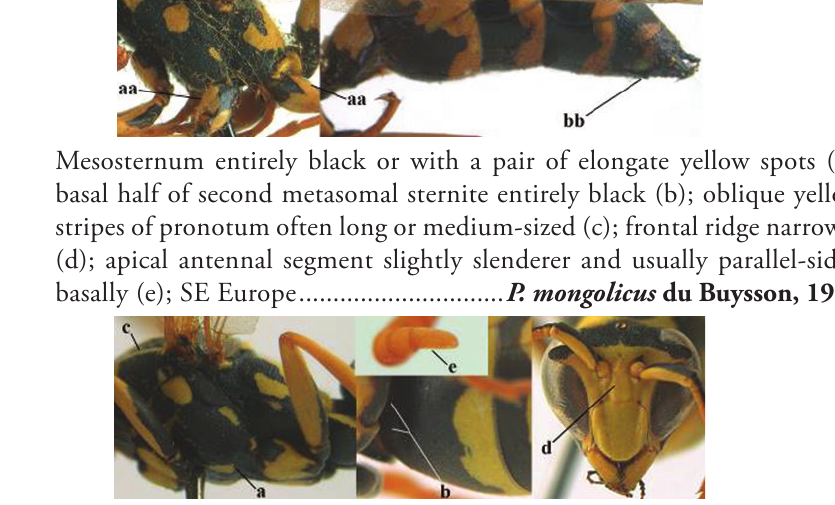
– Mesosternum predominantly or entirely yellow (aa); basal half of second ster- nite with yellow pattern, varying from a pair of very small sublateral yellow spots to mainly yellow (bb), if sometimes entirely black ( P. gallicus ) then pro- notal transverse yellow band moderately widened; oblique yellow stripes of pronotum variable, sometimes absent (cc); frontal ridge wider (dd); apical antennal segment slightly less elongate and more or less widened basally (ee), but comparatively slender in P. bischoffi (eee) ............................................